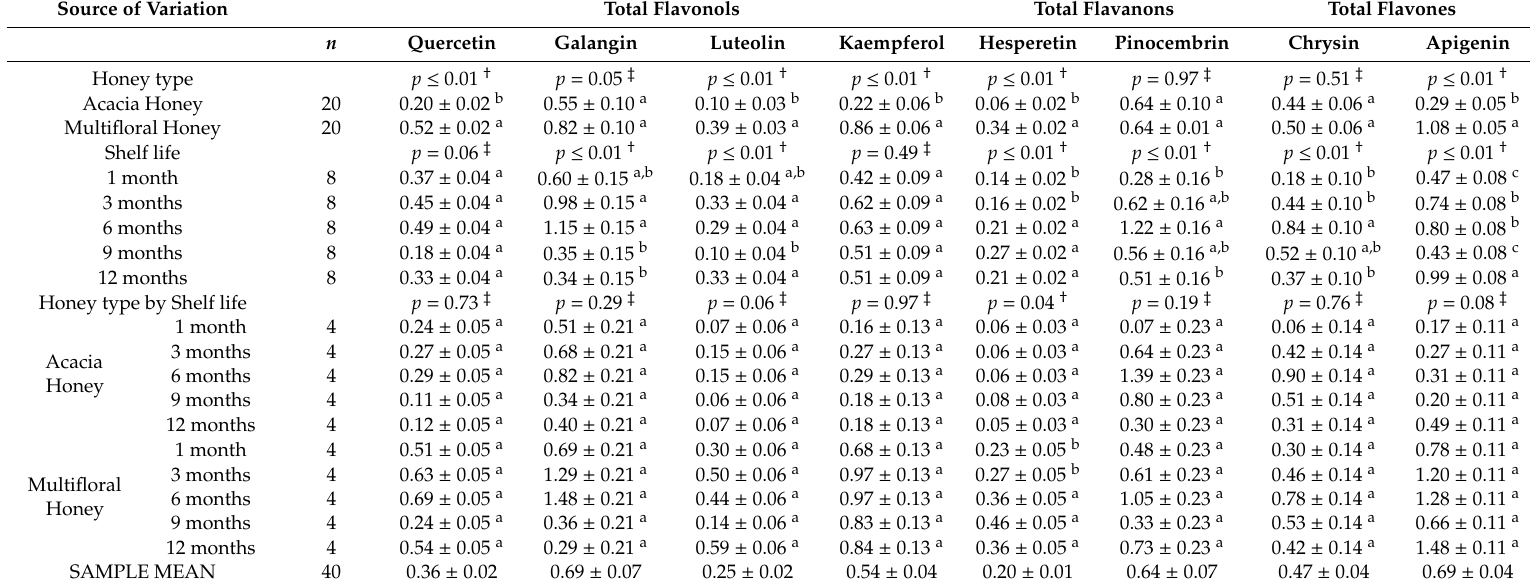
Table 2. The changes in individual flavonoids in acacia and multifloral honey samples during 1, 3, 6, 9 and 12 months of storage. Source of Variation Total Flavonols Honey type